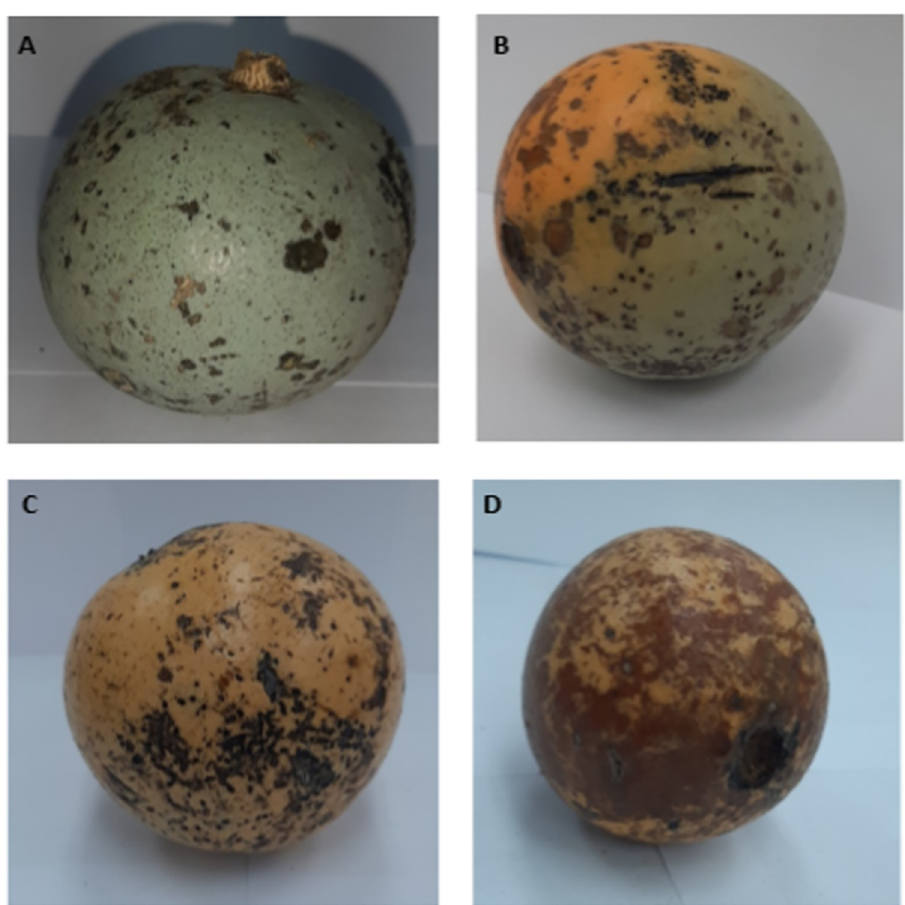
Fig 2. Strychnos madagascariensis fruit at four stages of ripeness. (A) stage 1 –unripe-green fruit; (B) stage 2 –semi- ripe fruit; (C) stage 3 –ripe fruit; (D) stage 4 –over ripe fruit.